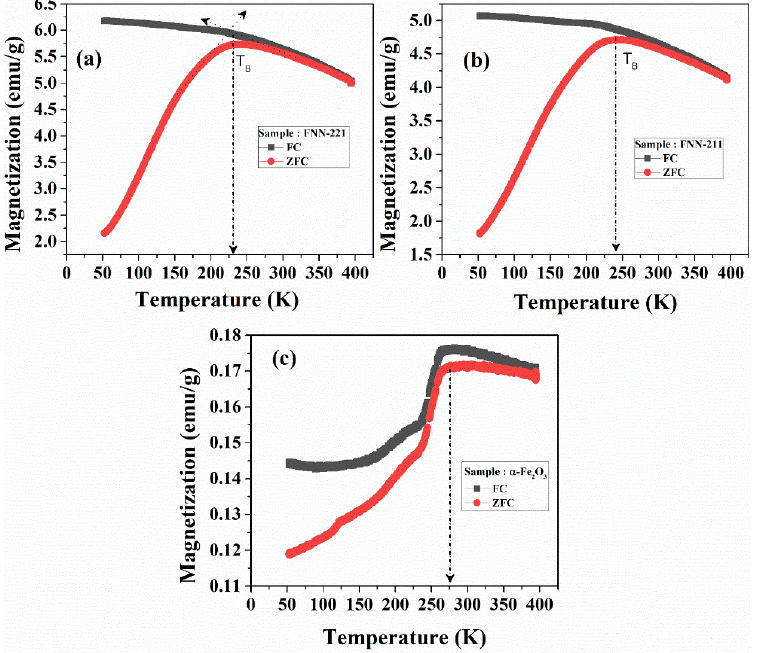
Figure 4. Temperature dependent ZFC-FC magnetization of ( a ) FNN-221 and ( b ) FNN-211 ( c ) α -Fe 2 O 3 compounds.